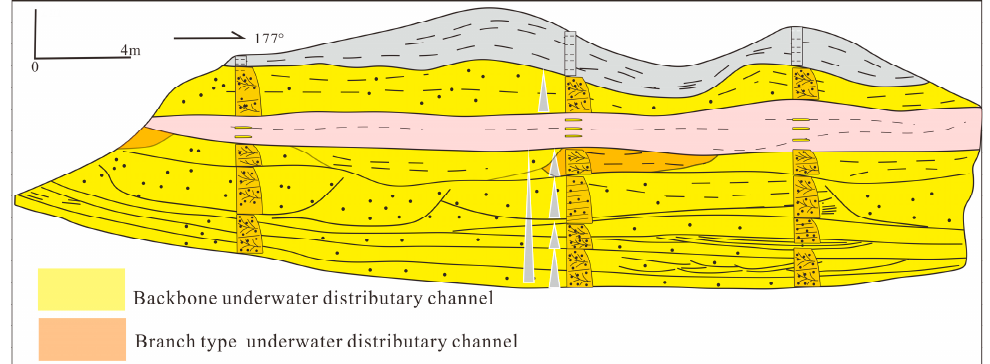
Figure 6. Architecture model of underwater distributary channel of braided river delta front in Shenmu area, Ordos Basin, China.